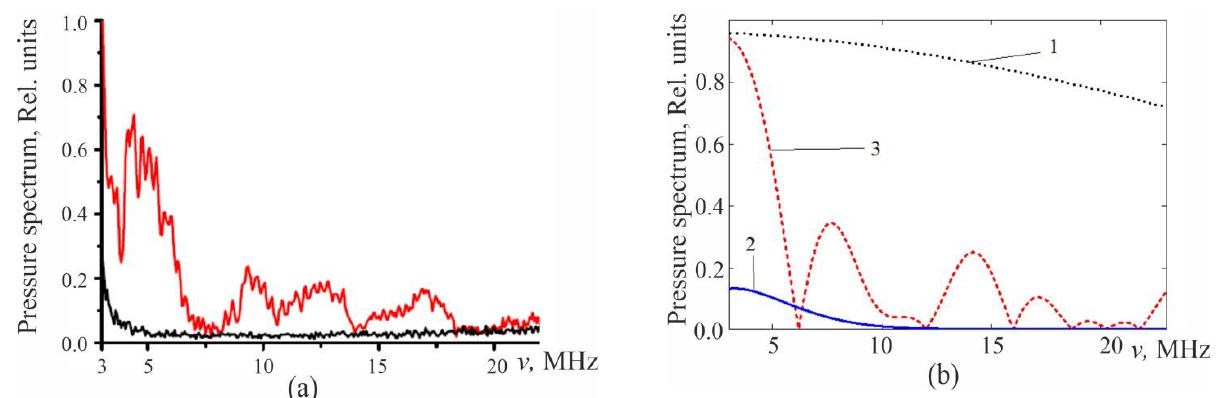
Figure 7. Experimental and model US spectra generated with 1μm sphere coating. ( a ) Experi- mental US spectra with sphere coating (red) and without coating (black) [8]. ( b ) Model US spectra: 1—spectrum of exciting laser radiation. 2—without spheres from a clean fiber spectrum; 3— spectrum with spheres; diameter of the spheres is 200 μm.